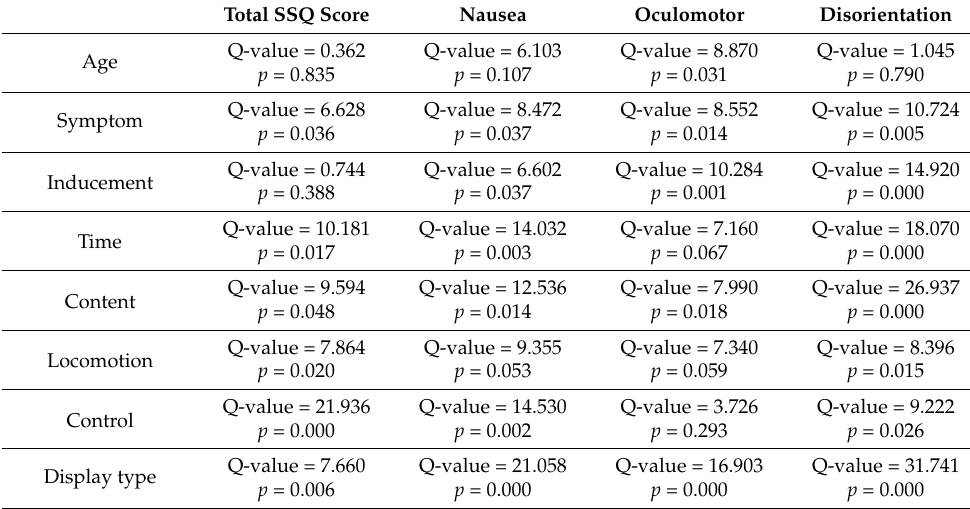
Table 4. Statistical analysis results for SSQ Scores.